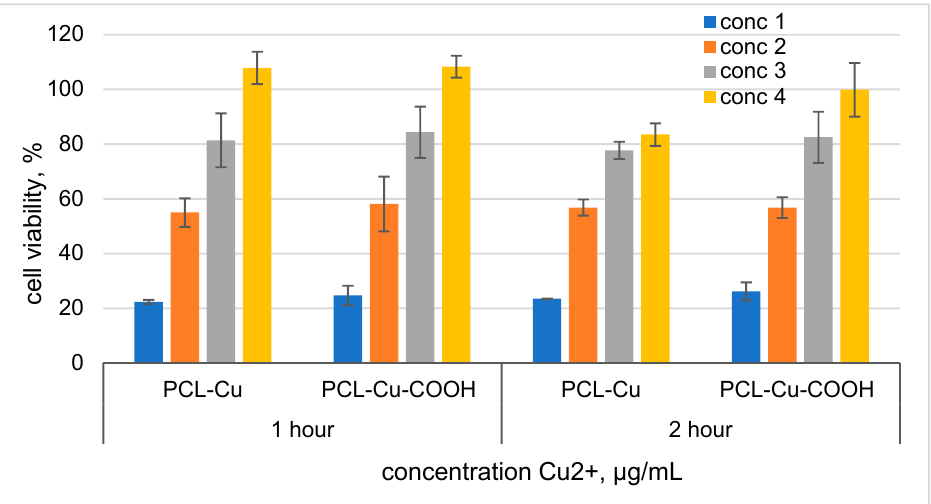
Figure 12. Cell viability effect of media after soaking PCL ‐ Cu and PCL ‐ Cu ‐ COOH for 1 and 2 h. Cells were seeded in 96 well plates after 24 h media was replaced by medium soaked PCl ‐ Cu and PCL ‐ Cu ‐ COOH. For PCL ‐ Cu 1 h: с onc 1 = 2.3 μ g/mL; с onc 2 = 1.15 μ g/mL, conc 3 = 0.57 μ g/mL and conc 4 = 0.29 μ g/mL. PCL ‐ Cu 2 h: с onc 1 = 3.5 μ g/mL; с onc 2 = 1.75 μ g/mL, conc 3 = 0.87 μ g/mL and conc 4 = 0.44 μ g/mL. For PCL ‐ Cu ‐ COOH 1 h: с onc 1 = 1.8 μ g/mL; с onc 2 = 0.9 μ g/mL, conc 3 = 0.45